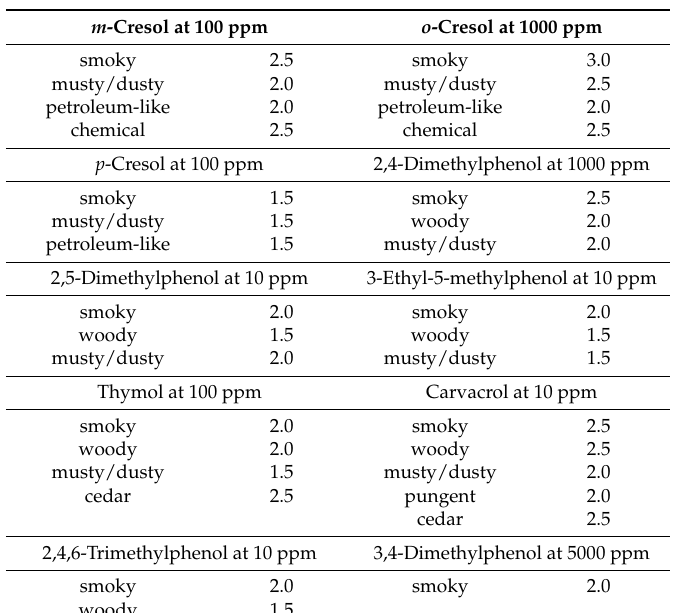
Table 3. Odor profiles of phenol derivatives illustrating smoked characteristics with descriptions and intensities